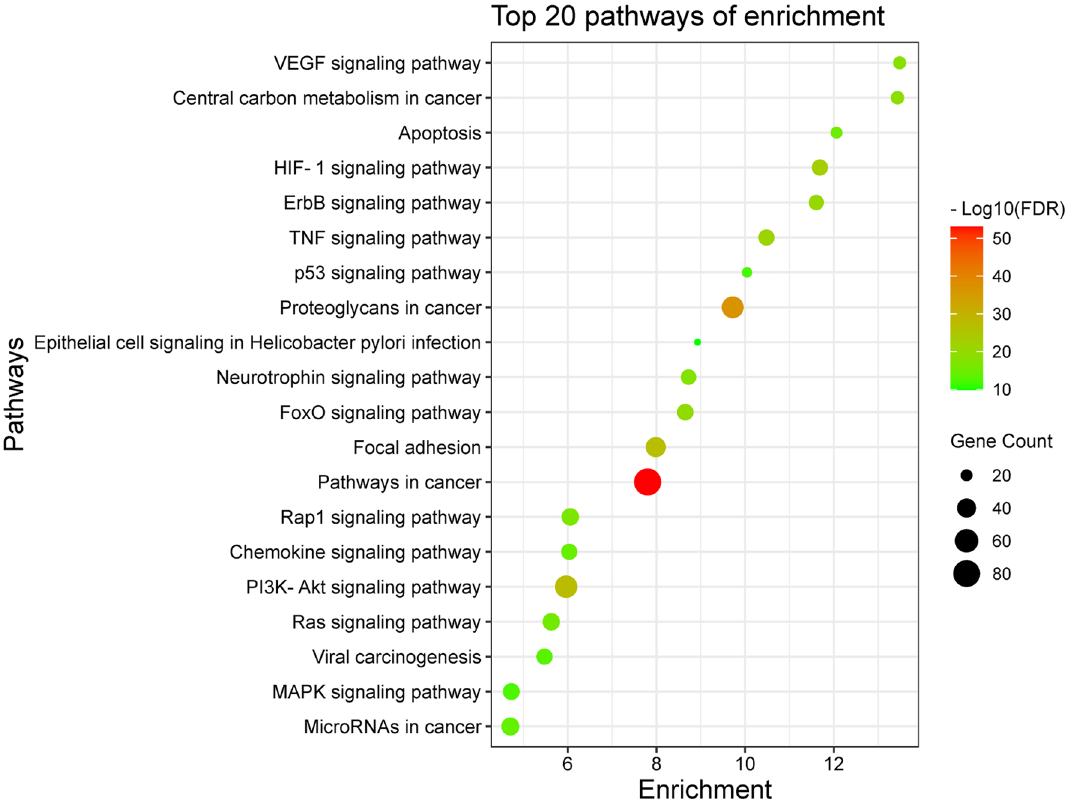
Figure 4. The top 20 potential KEGG pathway enrichment of screened target genes in GC (http:// www. bioin forma tics. com. cn/).